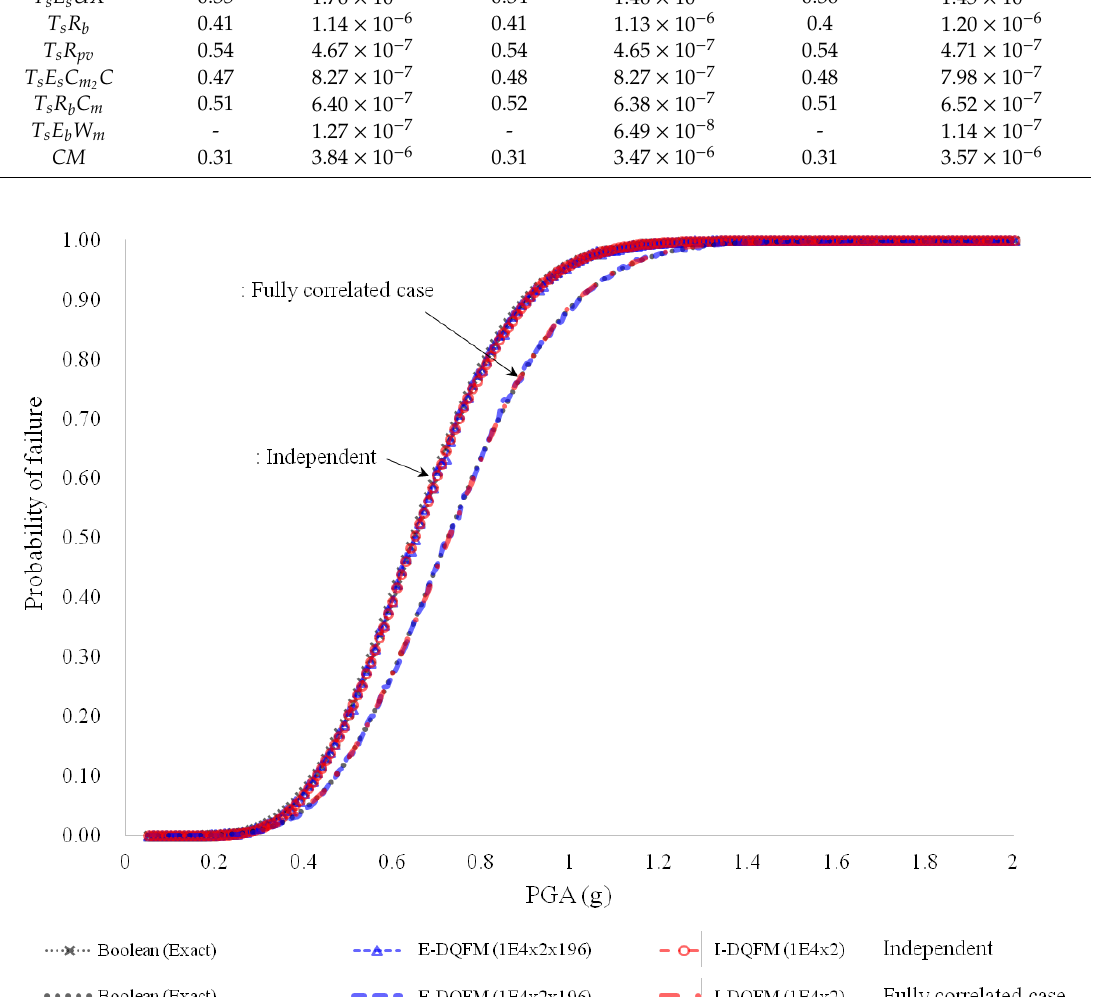
Figure 12. Comparison of mean seismic fragility curves: “LGS NPP CM sequence”. Table 4. Mean seismic risk for “LGS NPP”: Independent case.